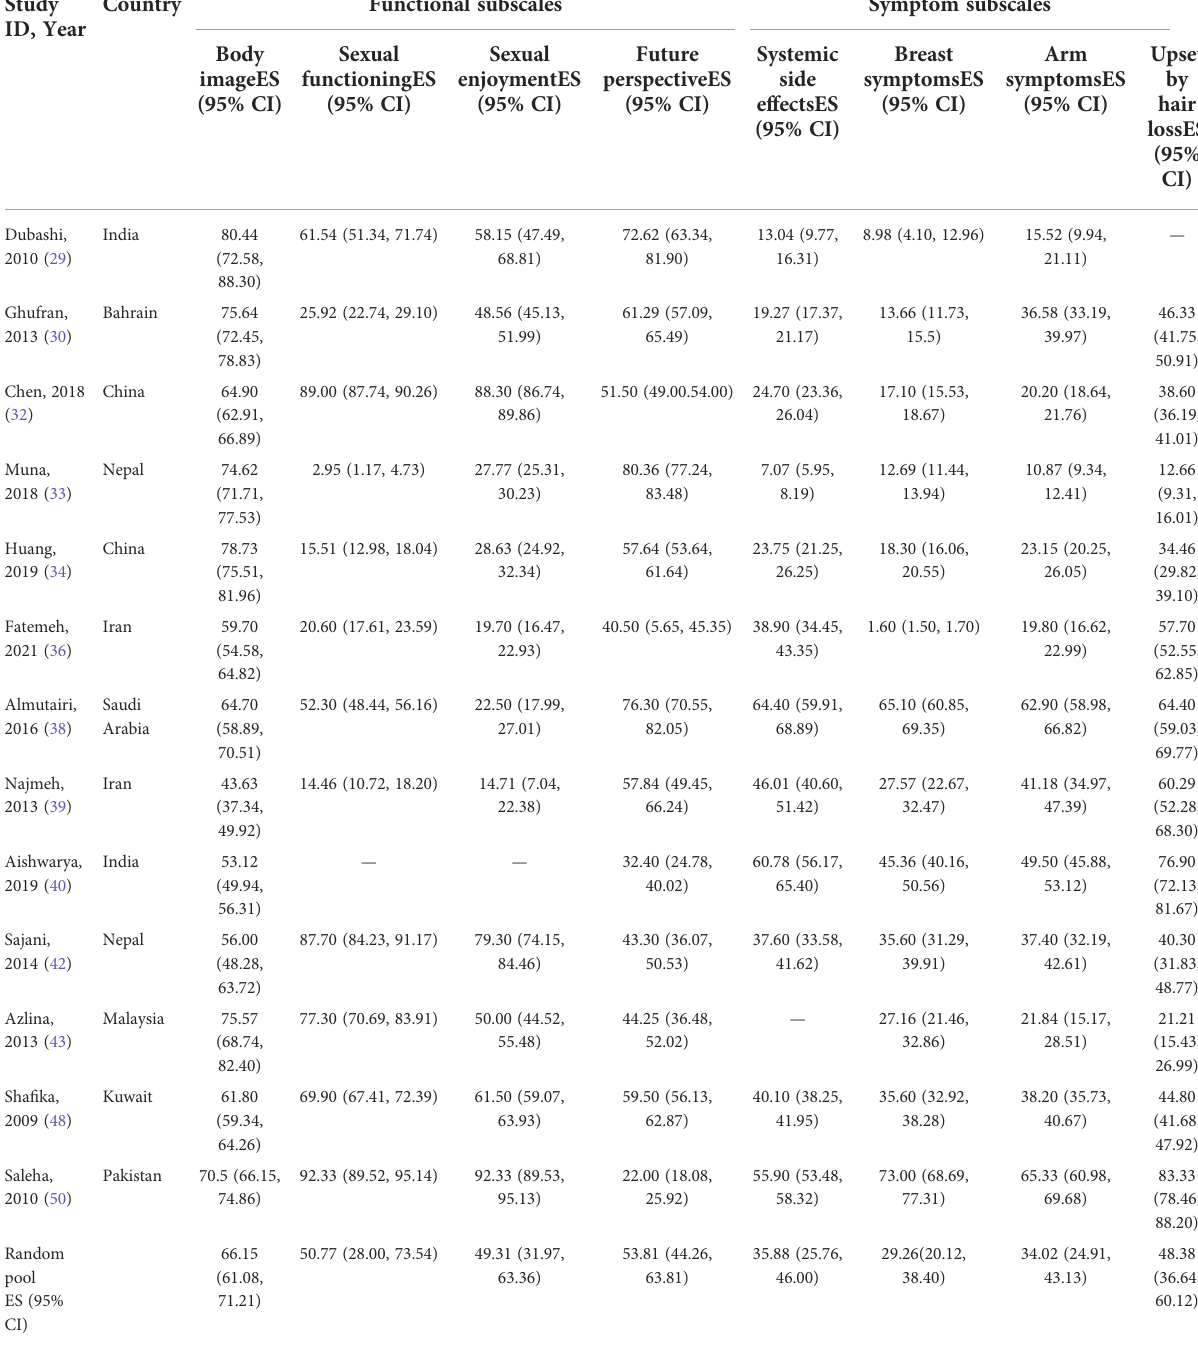
TABLE 4 Functional and symptom subscales of EORTC QLQ-BR23. Study ID, Year